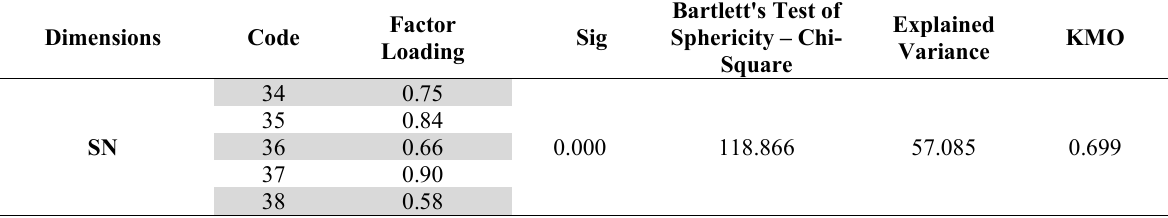
EFA analysis for the items representing the Moderator Variable (Subjective Norms) Dimensions Code